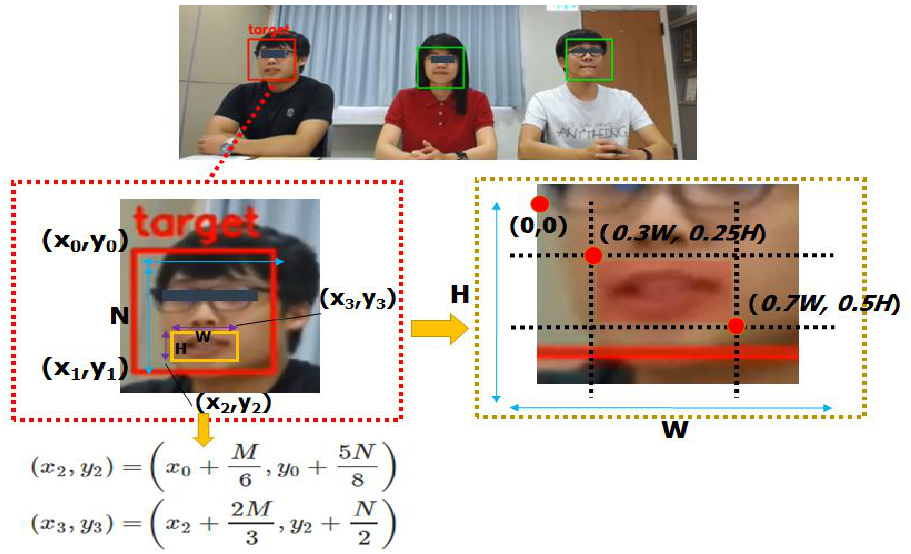
Figure 2. Redistribution of human face and lip features.